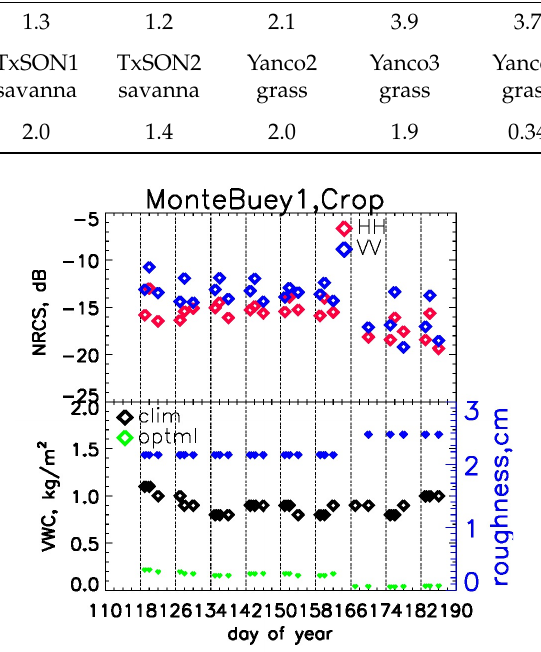
Figure 4. Retrievals of VWC and roughness at the Monte Buey site using SMAP data in 2015. clim and optml refer to VWC values from climatology and optimized